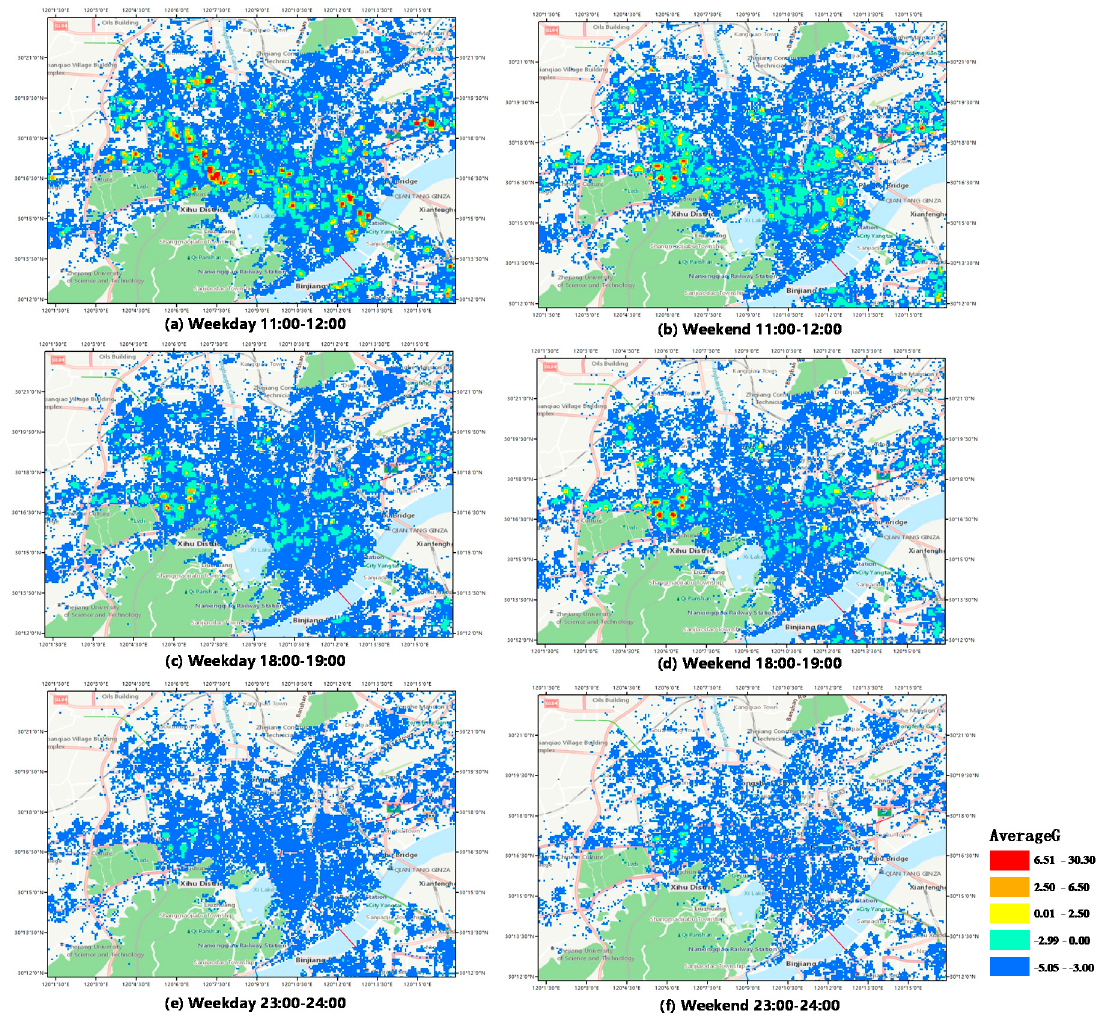
Figure 6. Delivery hotspot distribution during typical time periods.